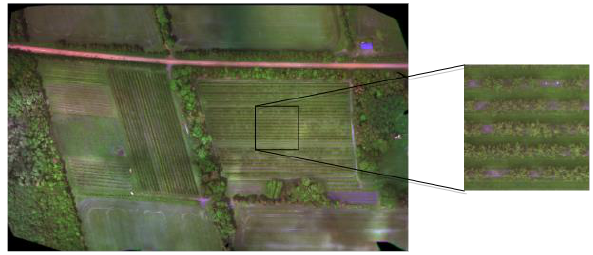
Figure 1 . Example of model’s input image.